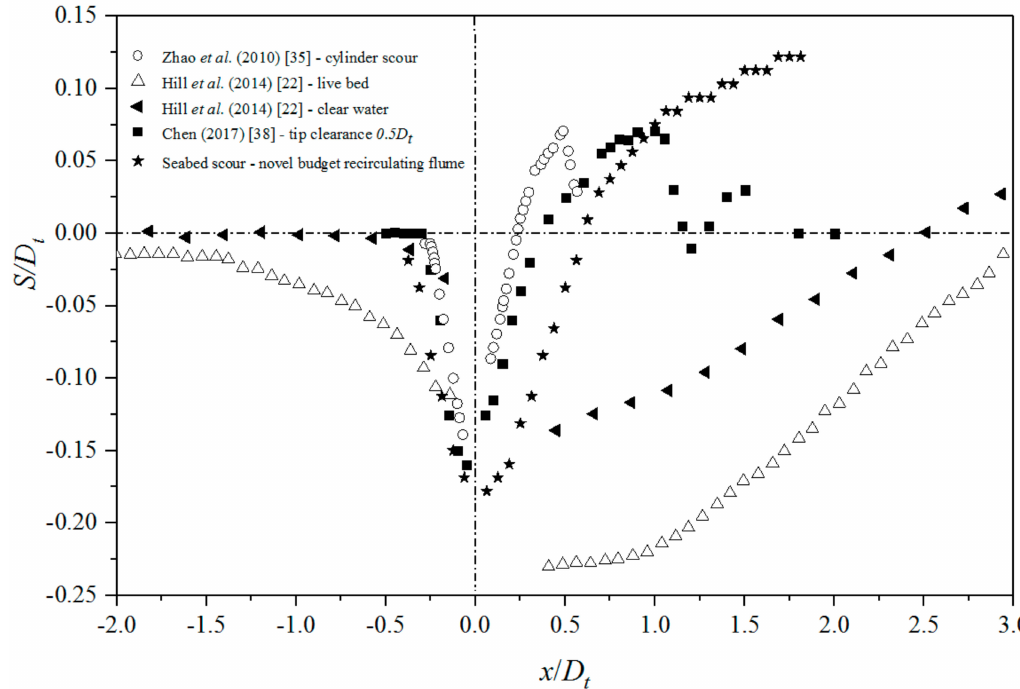
Figure 12. Comparison of scouring